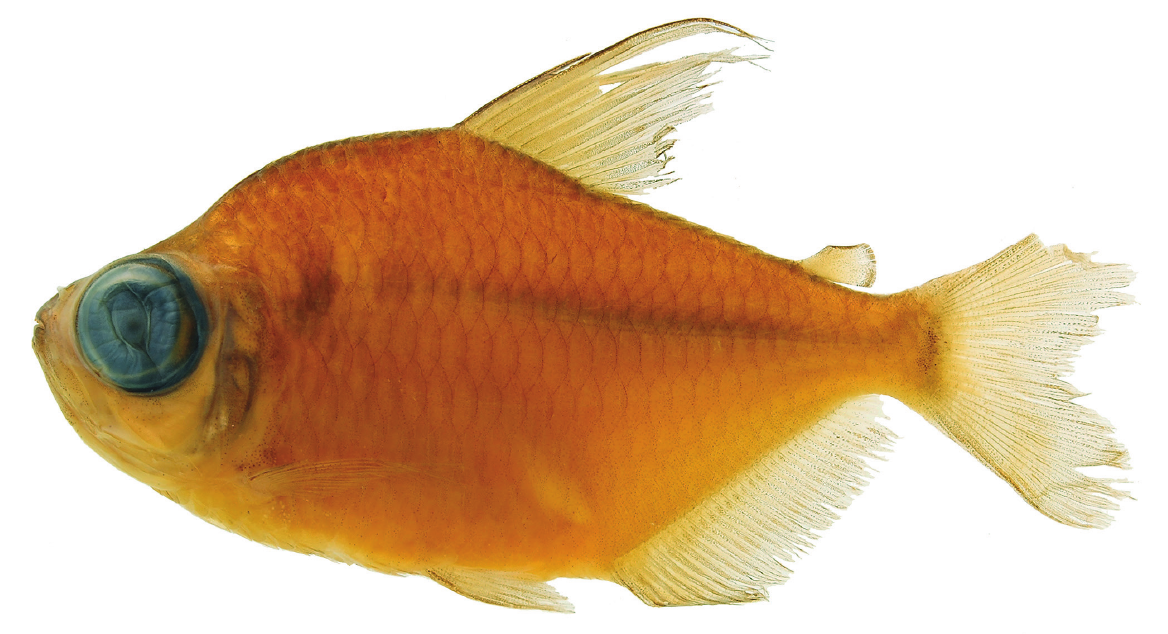
Fig. 2. Tetragonopterus manaos , paratype, MZUSP 123507, 62.8 mm SL, Brazil, Manaus, Anavilhanas National Park, rio Negro, Amazon